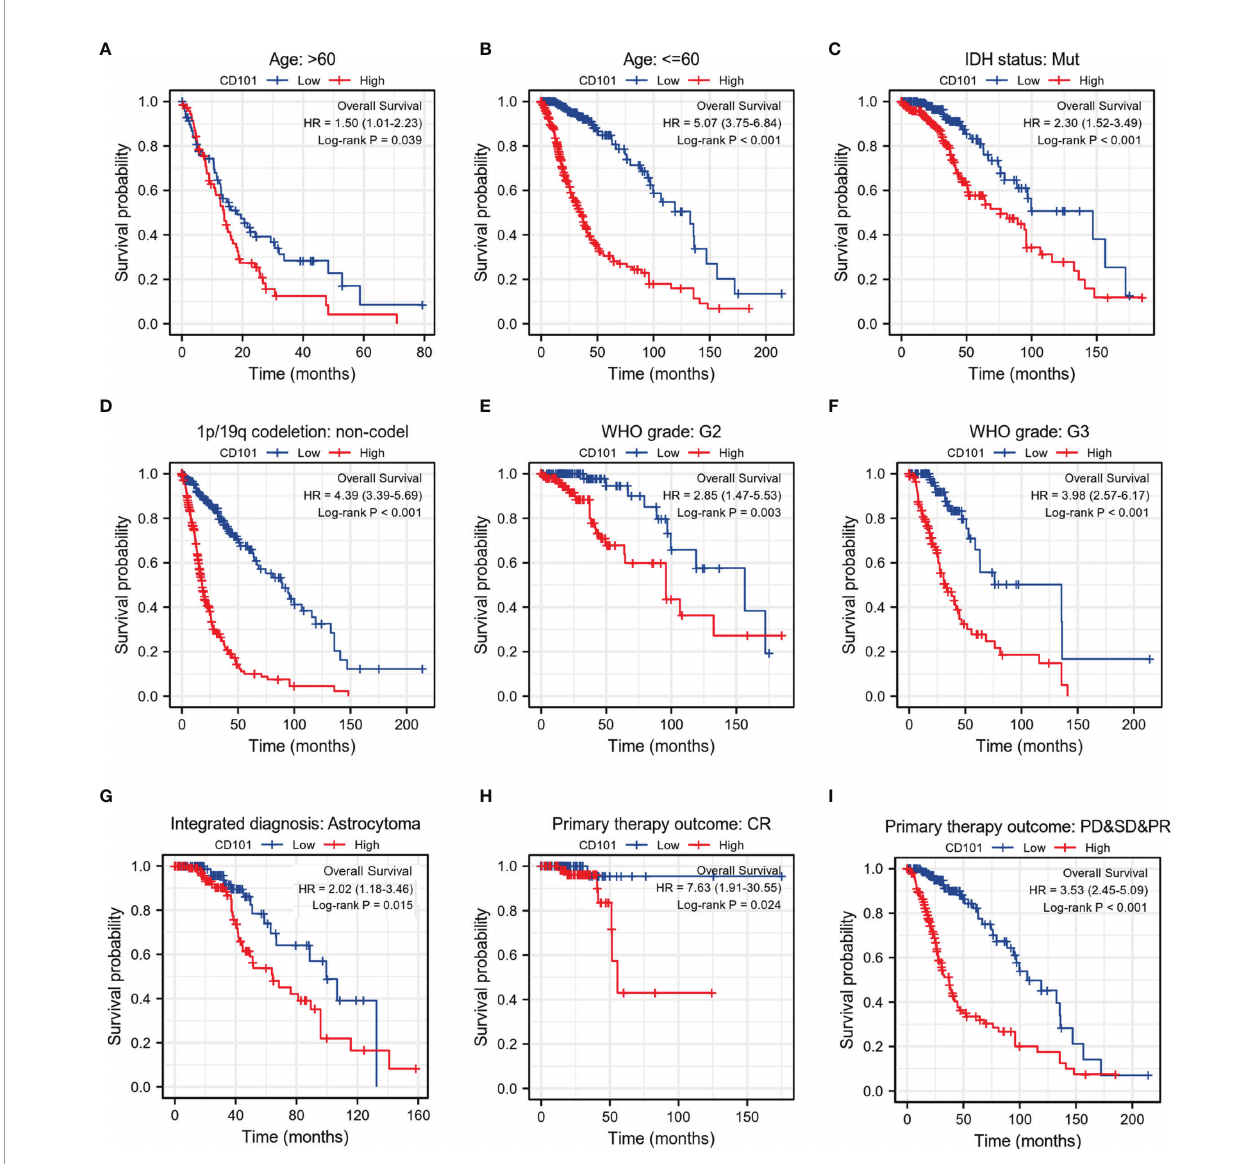
FIGURE 4 | Associations between CD101 expression level and the OS in different clinical subgroups of glioma in TCGA database. (A) Age > 60. (B) Age ≤ 60. (C) IDH status: Mut. (D) 1p/19q codeletion: non-codeletion. (E) WHO grade: G2. (F) WHO grade: G3. (G) Integrated diagnosis: astrocytoma. (H) Primary therapy outcome: CR. (I) Primary therapy outcome: